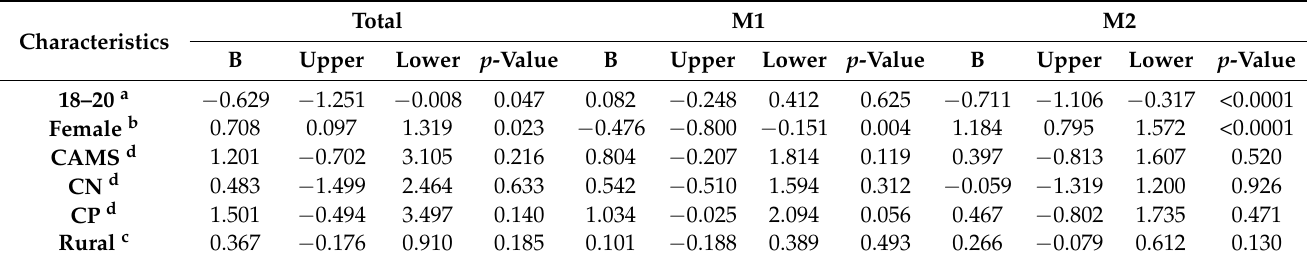
Table 4. Generalized linear model for the association of students’ characteristics and their knowledge scores of various models.